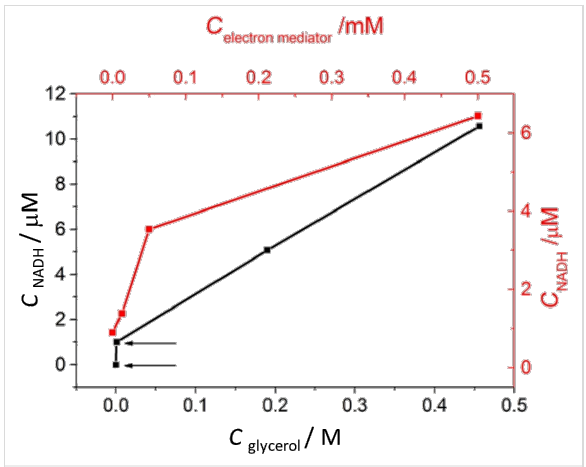
Figure 10: Photoreduction of NAD + as a function of concentration of glycerol (black line) and [Cp*Rh(bpy)H 2 O]Cl 2 (red line) under visible light irradiation in the presence of [CrF 5 (H 2 O)] 2 − @TiO 2 (irradiation time; 6 h).